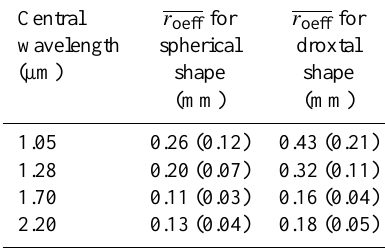
Table 6. Mean optical effective radius ( r oeff , mm) obtained from the measurement-derived surface albedo at four 0.1µm-wide wave- bands centred at 1.05, 1.28, 1.70, and 2.20µm. The effective vari- ance used in the model calculations is that at the surface layer. The standard deviation of r oeff among the eight case studies is given in parentheses.